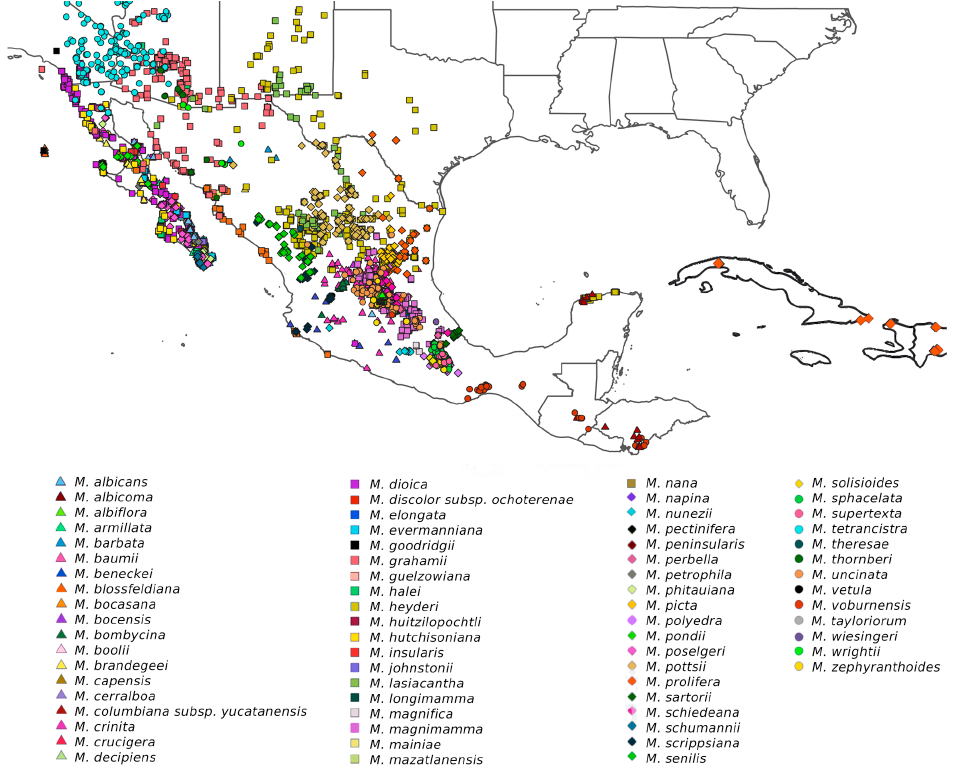
Figure 1. World geographical distribution of the 70 taxa of Mammillaria . Geographical distribution per taxon is showed in detail in Supplementary Materials (File S1).